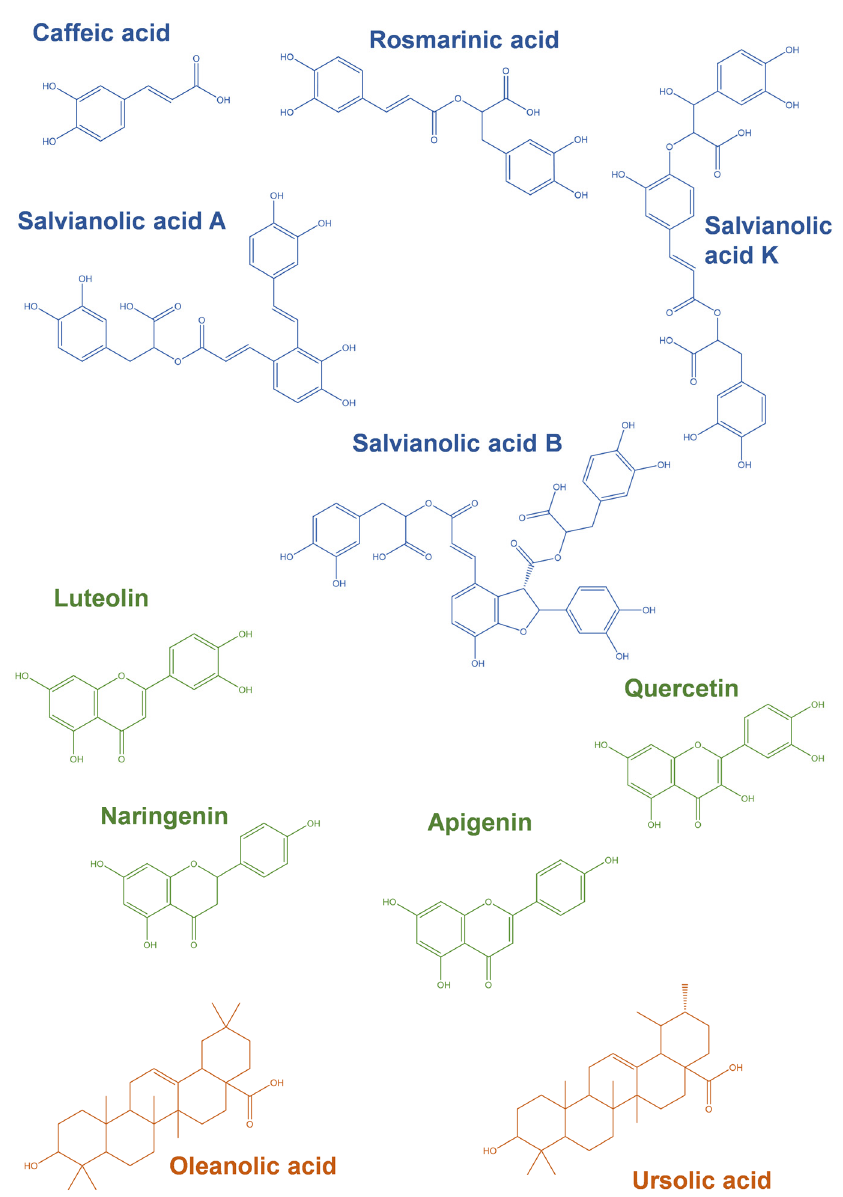
Figure 4. Chemical structures of common phytochemicals identified in Thymus spp. extracts. Blue: phenolic acids; green: flavonoids; orange: pentacyclic triterpenoids.